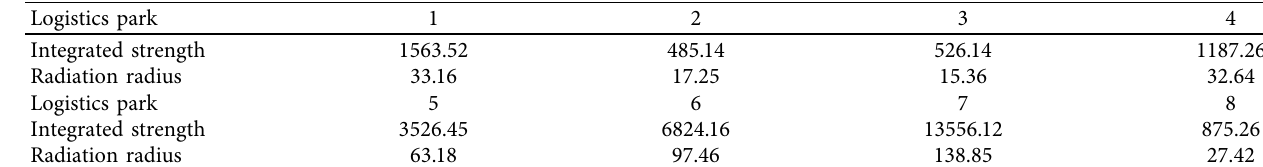
Table 8: Integrated strength and radiation radius of each logistics